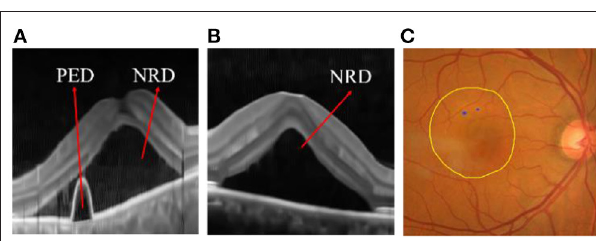
FIGURE 12 | (A) Pigment epithelium detachment (PED) and neurosensory retinal detachment NRD; (B) NRD (C) detachment area (DA) (the internal area marked by yellow line) and leakage point (LP) (the blue